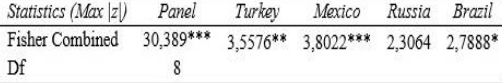
Table 9: Variance Ratio Test of Cointegration Residuals